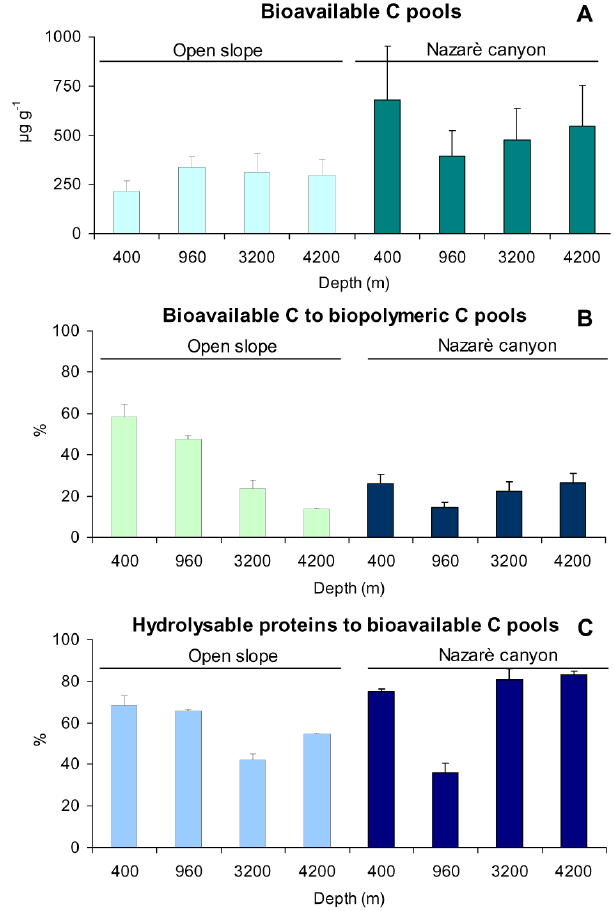
Fig. 7. Spatial distribution of (A) bioavailable C concentrations, (B) contribution of bioavailable C to biopolymeric C pools and (C) con- tribution of hydrolysable proteins (converted into C equivalents) to bioavailable C pools in surface sediments of the Nazar`e canyon and adjacent open slope of the Portuguese margin. Standard deviations are